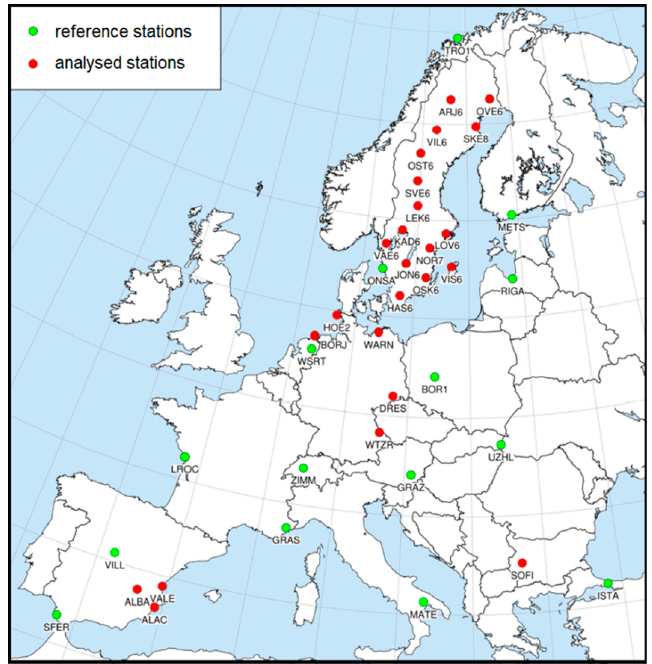
Figure 1. Map of the stations included in this research. Red points indicate stations equipped with analyzed antennas, while green points indicate the reference stations used for network alignment. Table 1. Solutions prepared in this study. PCC—phase center correction.